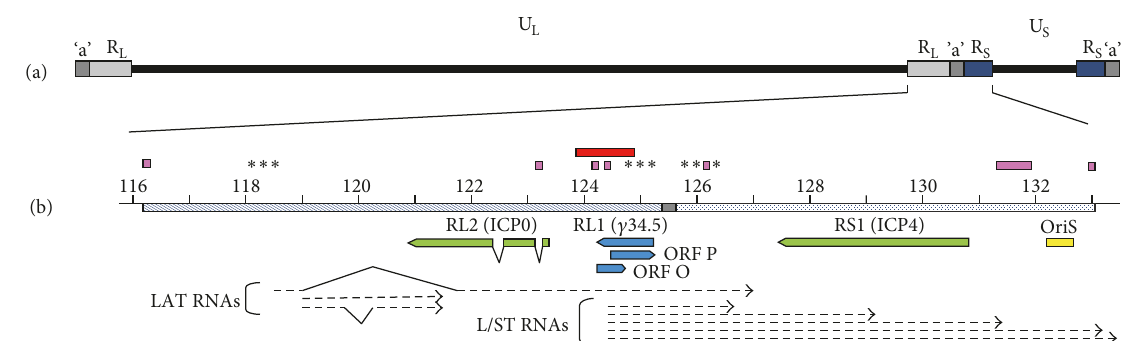
Figure 2: Genomic organization of BV. The BV genome is comprised of two unique regions (U homologous to the UL1–UL56 and US1–US12 genes of HSV are located, respectively (a). The U regions (R an R , resp.) with the ‘a’ repeat present at the ends of the genome and between the internal copies of R L S regions are enlarged in (b) to indicate the position of the following features discussed in the text: predicted ORFs (green), HSV ORFs not found in BV (blue), the origin of DNA replication in R region deleted in the E90 Δ RL1 mutant